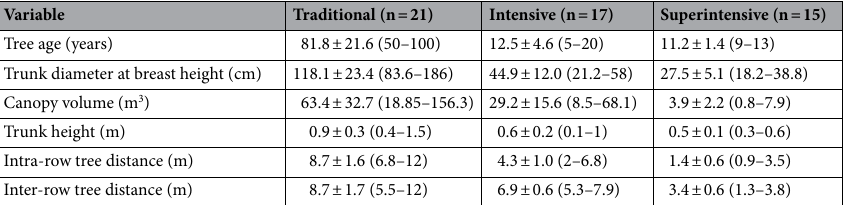
Table 1. Summary statistics (mean ± SD; min.-max.) of the structural variables used to characterise the three orchard types retrieved through cluster analysis.